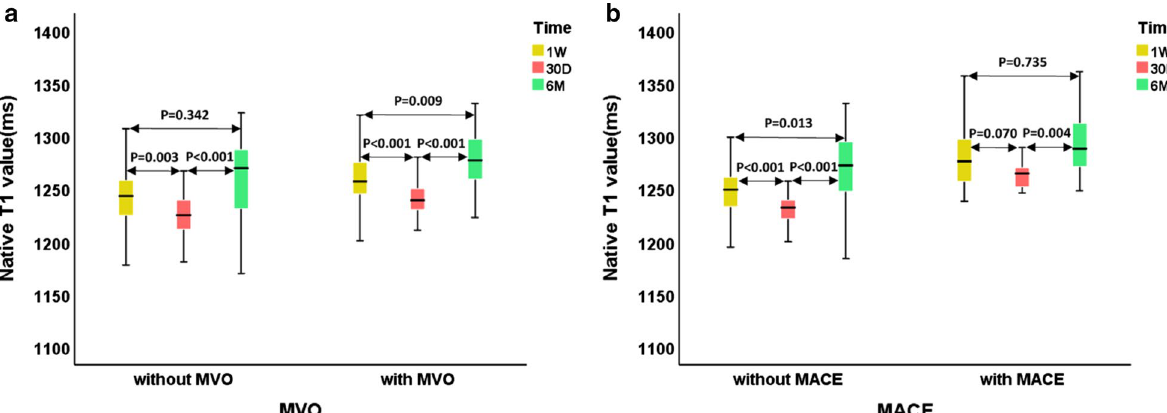
Fig. 3 The box‑plots (25th percentile, median, and 75th percentile) represent dynamic changes in native T1 values of remote myocardium on three occasions. In patients with and without MVO, remote T1 values were lowest at 30 days and highest at 6 months ( A ). In patients with and without MACE, remote T1 values were lowest at 30 days ( B )